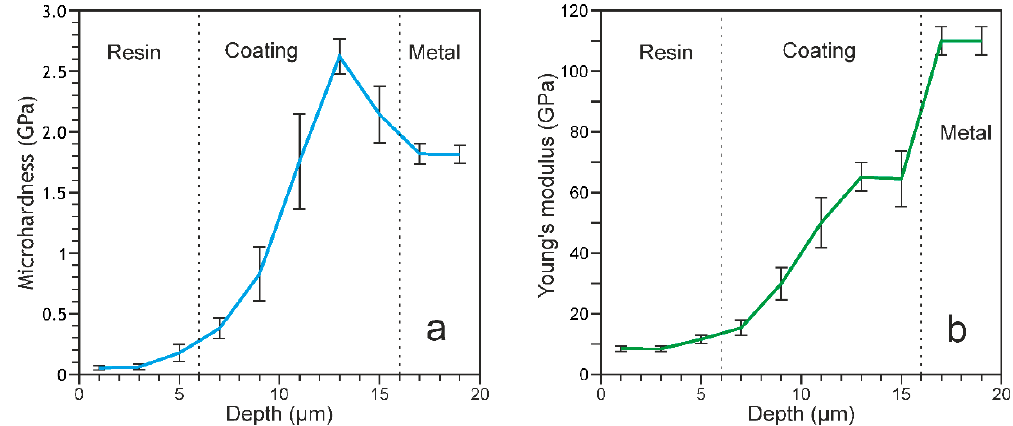
Figure 8. Distribution ( a ) microhardness and ( b ) Young’s modulus by thickness for PEO-coating.